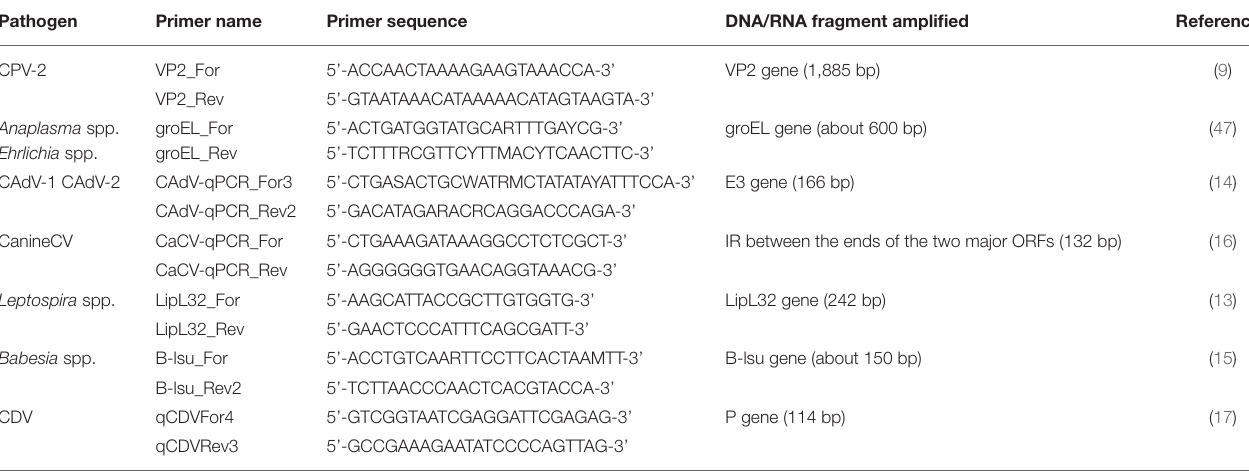
TABLE 1 | Primers used for molecular detection of viral, bacterial and parasitic DNA and viral RNA.